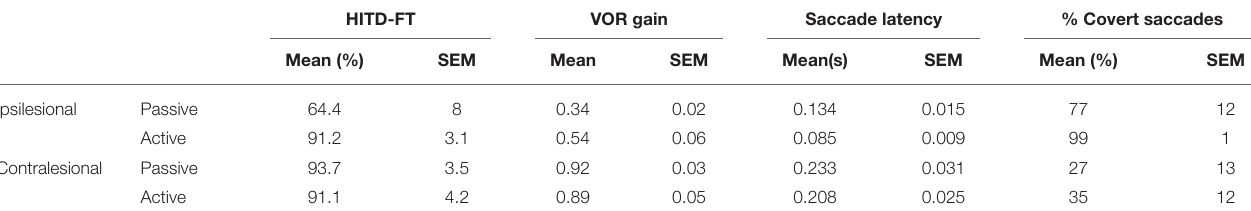
TABLE 1 | Recorded performance during head-impulses in ipsilesional and contralesional directions.